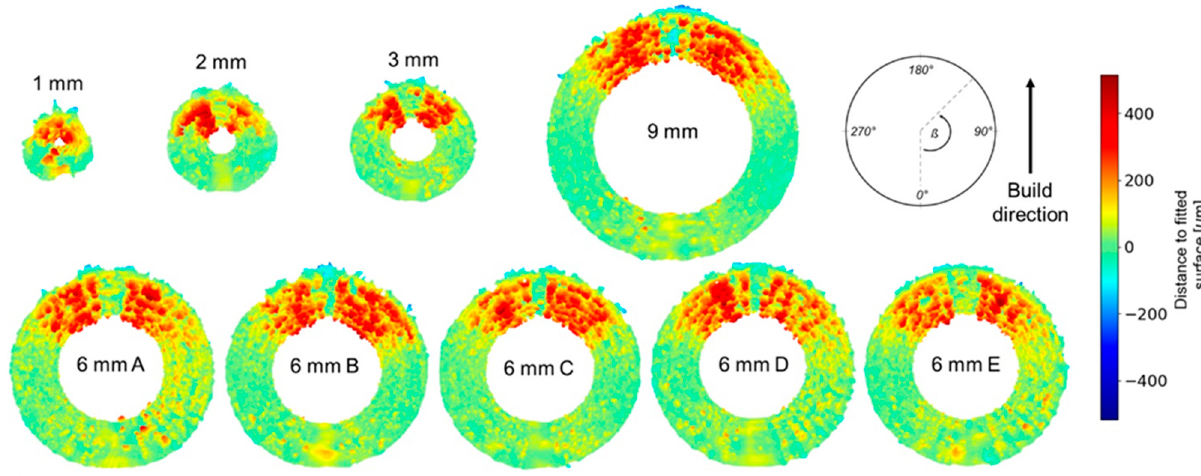
Figure 10. Overview of the investigated channels showing dross formation and roughness.